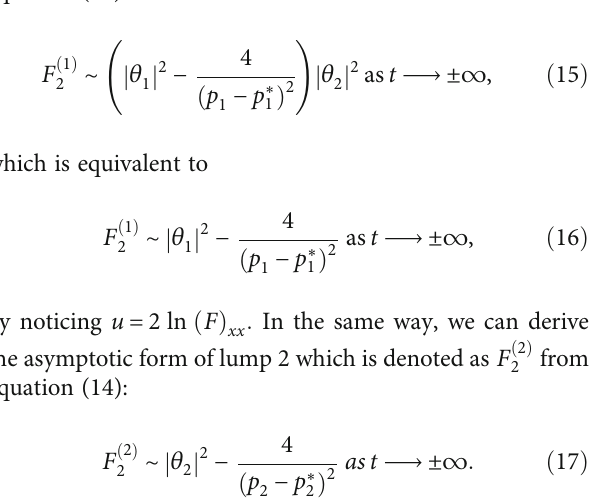
Þ : Figure 1 shows the 1-lump solution u = 2 ln ð F Þ ð θ 1